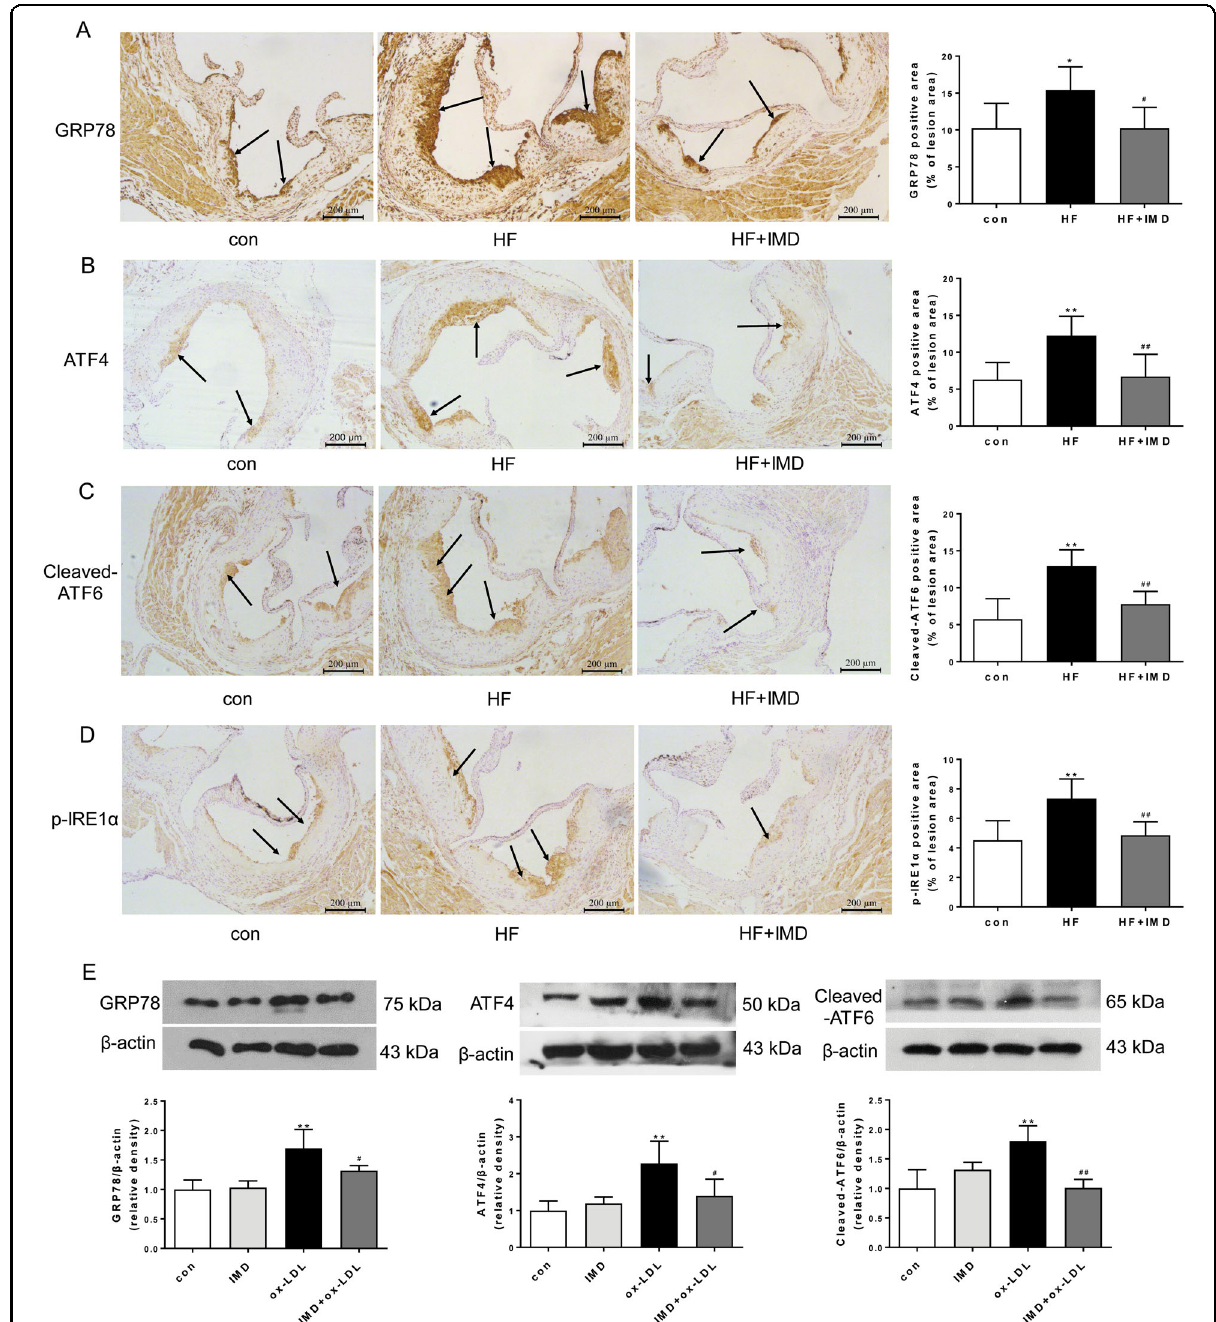
Fig. 3 IMD 1-53 inhibited endoplasmic reticulum stress (ERS) in atherosclerotic lesions. A – D Eight-week-old male ApoE − / − were fed a standard chow diet (con) or a high-fat diet (HFD) for 16 weeks. After 10 weeks of HFD feeding, ApoE – / – mice received either PBS or intermedin 1-53 (IMD 1-53 ) during the left 6 weeks of high-fat diet feeding. Representative images and quanti fi cation data of GTP78 ( A ), ATF4 ( B ), cleaved ATF6 ( C ), and p-IRE1 α ( D ) immunohistochemical staining at the aortic root of mice from each group. Black arrows indicate the area stained positively for GTP78, ATF4, cleaved ATF6, or p-IRE1 α . Scale bars, 200 μ m. n = 6. Data are mean ± SD. * P < 0.05, ** P < 0.01 compared with con, # P < 0.05, ## P < 0.01 compared with HF group; one-way ANOVA. E Western blot analysis of protein expression of GRP78, ATF6, and ATF4 in macrophages treated with PBS, IMD 1-53 , ox- LDL, and IMD 1-53 + ox-LDL. β -actin was a control for protein loading. Results are representative of four experiments. Densitometric analysis of protein levels is shown as a ratio to β -actin. n = 4. Data are mean ± SD. ** P < 0.01 compared with con, # P < 0.05, ## P < 0.01 compared with the ox-LDL group; one-way